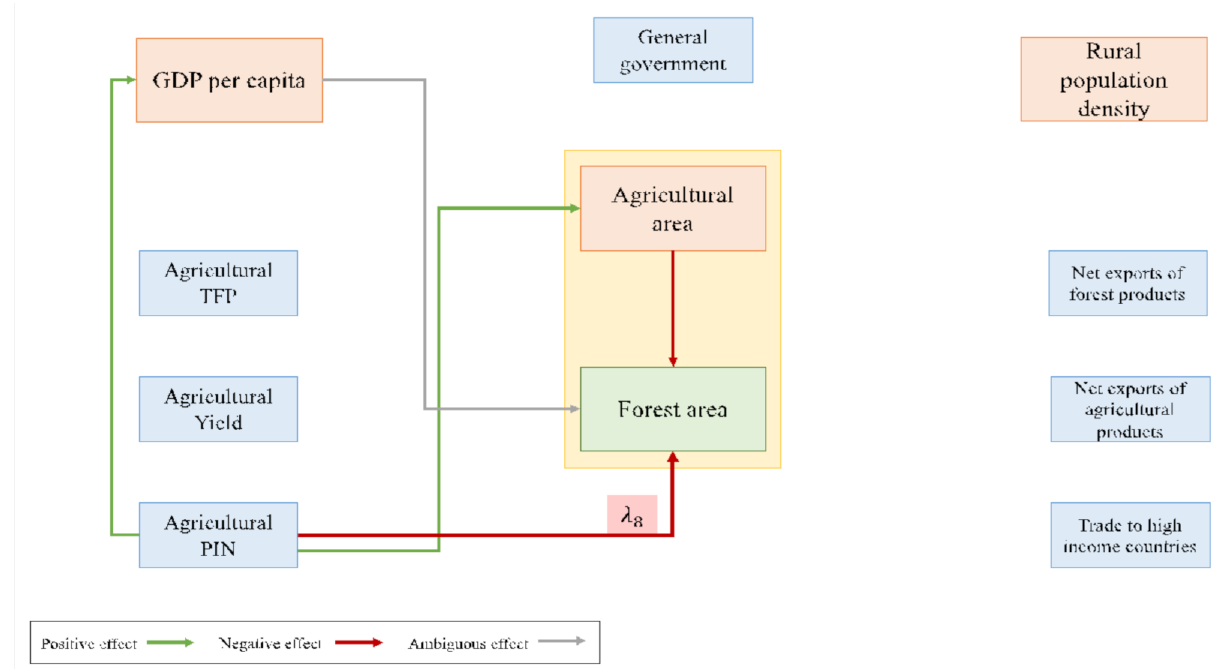
Figure A9. Estimating indirect effects of “Agricultural PIN”